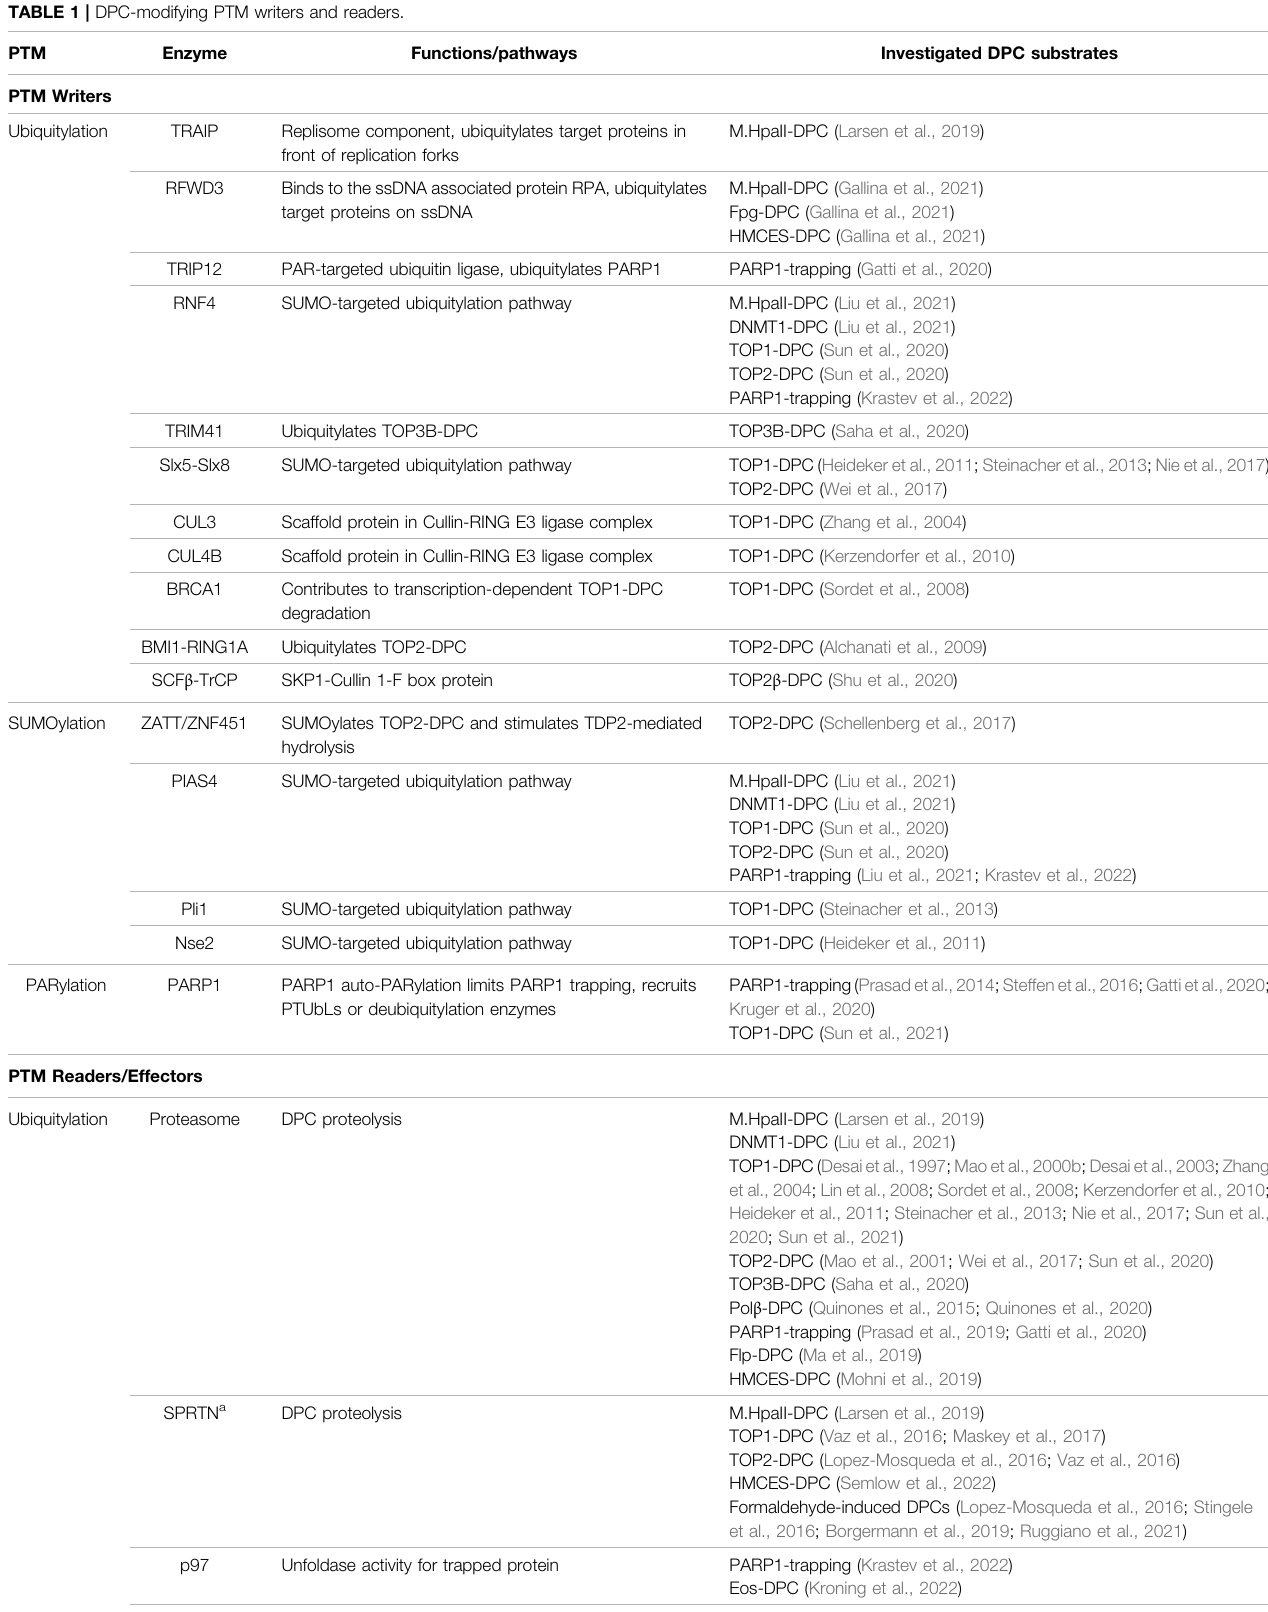
TABLE 1 | DPC-modifying PTM writers and